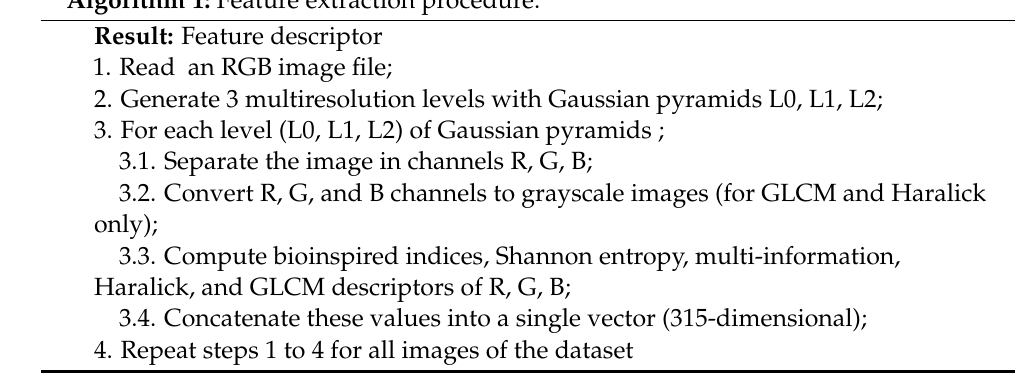
Algorithm 1: Feature extraction